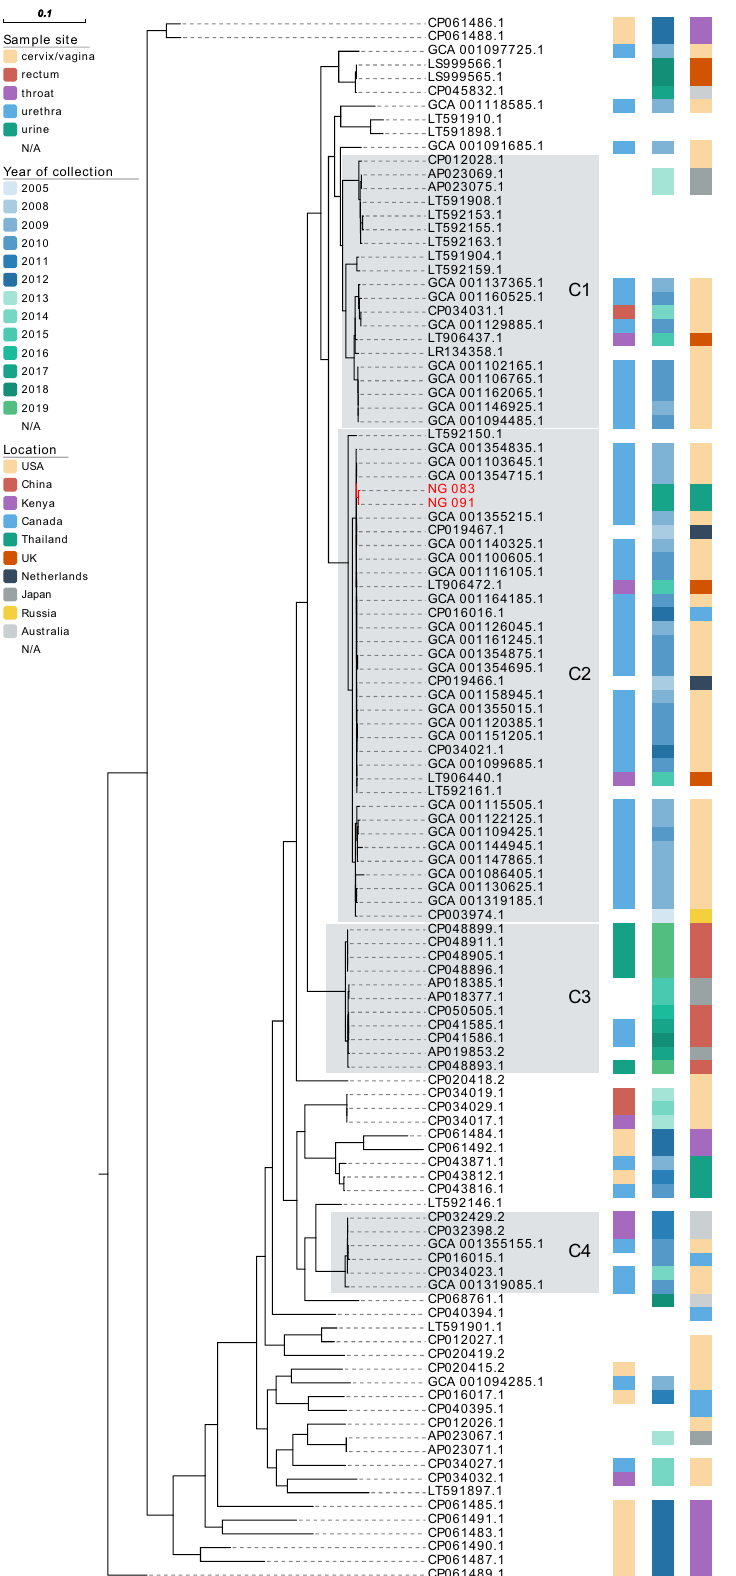
Figure 4. Phylogenetic analyses based on core genome from draft genomes of Neisseria gonorrhoeae NG-083 and NG-091 clinical isolated in Thailand and from varying N . gonorrhoeae WGS investigations conducted elsewhere (available on NCBI database) were determined for the number of single nucleotide polymorphisms (SNPs) by Core-Genome SNP Analysis. C1-C4 represent major